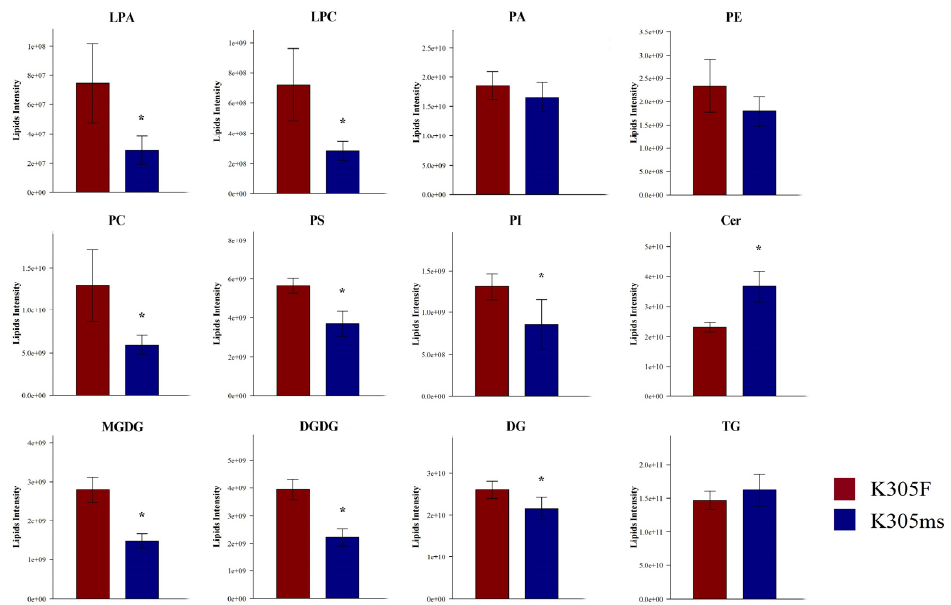
Figure 6. UHPLC-MS analysis of total lipids in ms305 (K305ms) and fertile sibling (K305F). PA, phosphatidic acid; LPA, lysoPA; PC, phosphatidylcholine; LPC, lysoPC; PE, phosphatidylethanolamine; PS, phosphatidylserines; PI, phosphatidylinositols; MGDG, monogalactosyldiacylglycerols; DGDG, digalactosyldiacylglycerols; DG, digalactosyldiacylglycerols; TG, triacylglycerols; Cer, ceramidase. Error bars indicate SD ( n = 8); * p < 0.05.